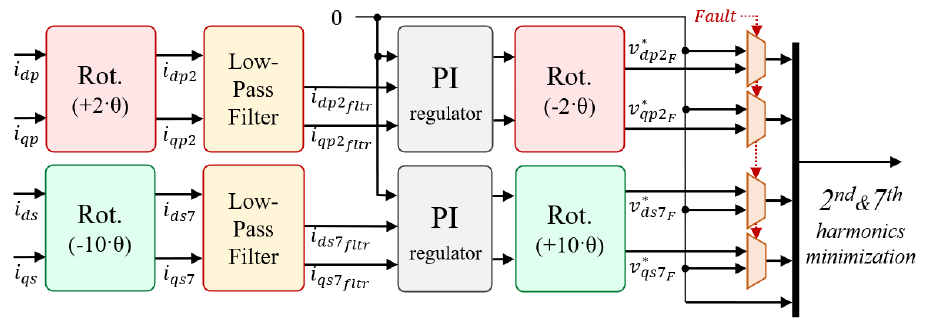
Figure 8. Harmonics minimization mechanism .